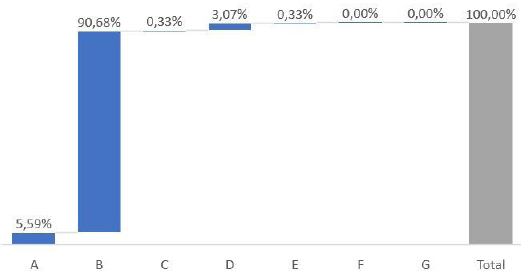
Figure 15. Destination of particles with ¼ ingot immersed (A= still in transit in the zinc bath; B= precipitated on the surface of the pot; C= precipitated on the surface of the internal snout bath; D= found the strip in the region 1; E= found the strip in region 2; F= found the strip in region 3; G= found the strip in region